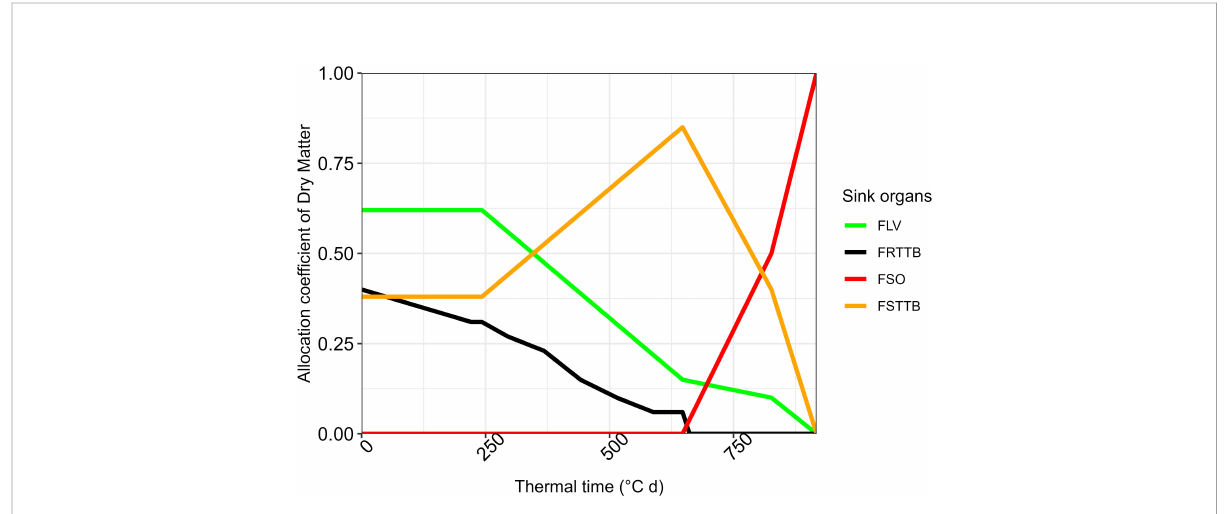
FIGURE 5 Allocation coef fi cient of dry matter as fractions. FLV, fraction to leaves; FRTTB, fraction to roots; FSO, fraction to storage organs; FSSTB, fraction to